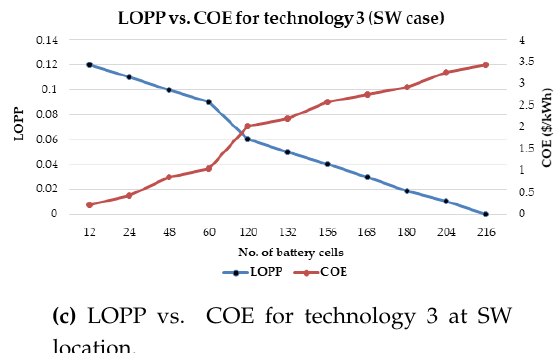
Figure 17. Technology selection for SW location.